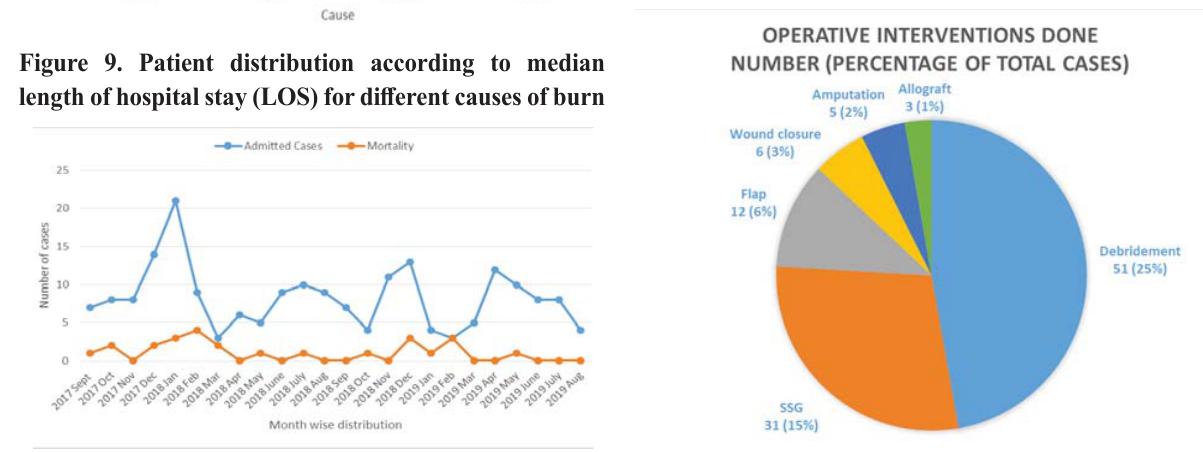
Figure 12. Patient distribution according to presence of comorbidities